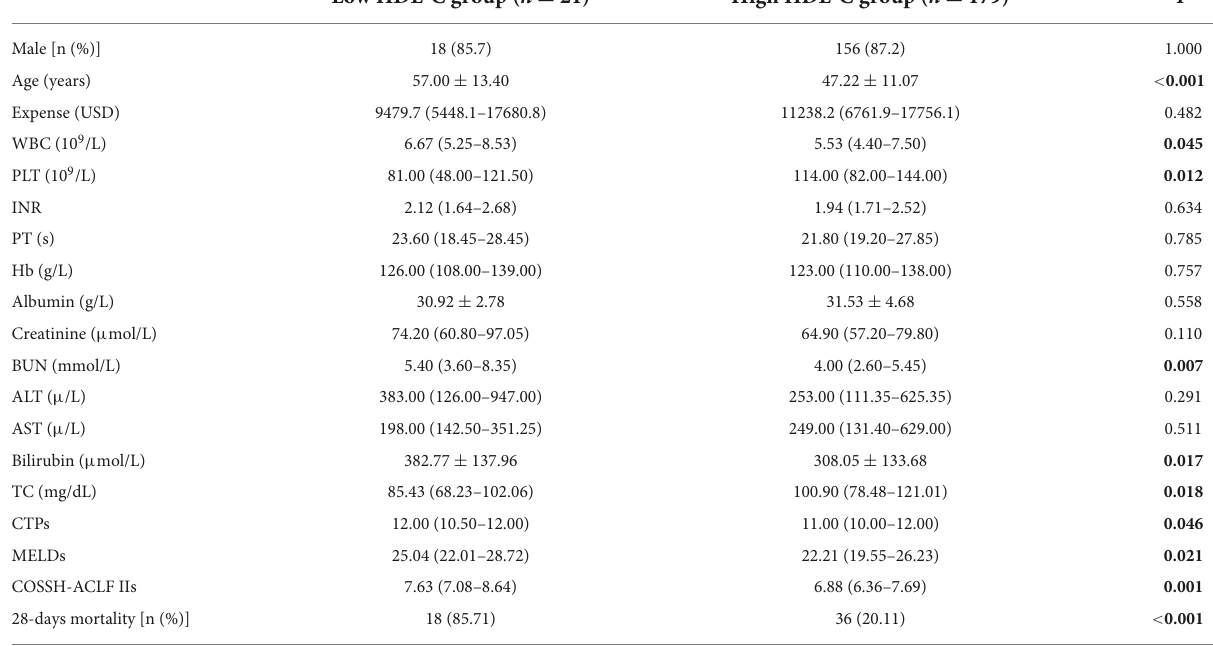
TABLE 3 Clinical data according to HDL-C